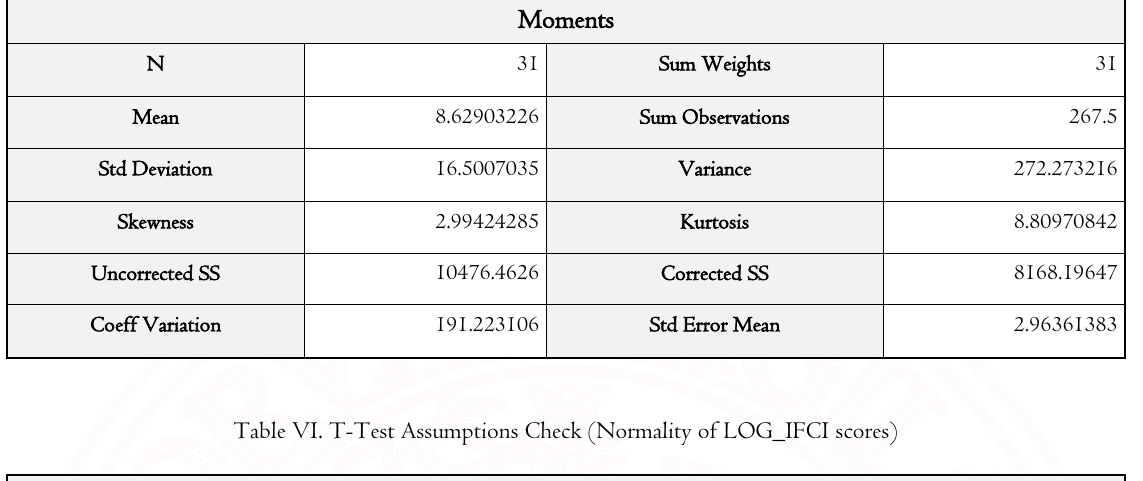
Table VI. T-Test Assumptions Check (Normality of LOG_IFCI scores)